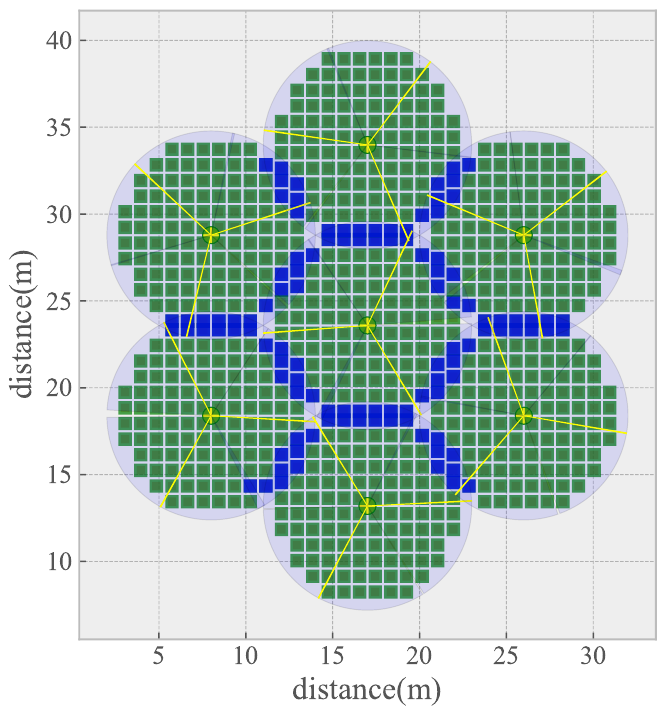
Figure 8. The coverage of the ideal scene after algorithm optimization.